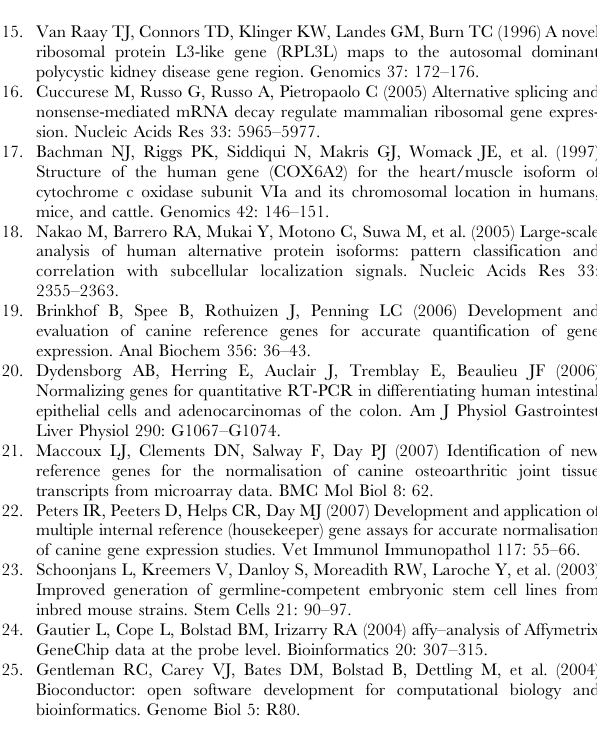
Figure S2 (A) Marginal means (estimated under the two-way ANOVA) of expression values for mRNAs encoding 69 respiratory chain proteins in each of the tissues, together with the 95 percent confidence interval. (B) Variance of expression levels for respiratory chain genes within replicates of tissues, representing biological variation between animals and technical error on measurements (triangles) compared to variance of expression between tissues (circles). Variance within replicated measurements was significantly smaller than variance of expression between different conditions (p , .0001 using Wilcoxon’s rank sum test). Figure S3 Conservation in mammals of tissue specific expression of Rpl3 isoforms (A) GDS596 record for probeset 211073_x_at in GEO, showing Rpl3 expression across 79 physiologically normal human tissues. (B) GDS596 record for probeset 206768_at in GEO, showing Rpl3l expression across 79 physiologically normal human tissues. Expression in heart and skeletal muscle was low for Rpl3 and high for Rpl3l and vice versa for the other tissues. Found at: doi:10.1371/journal.pone.0001854.s003 (2.75 MB